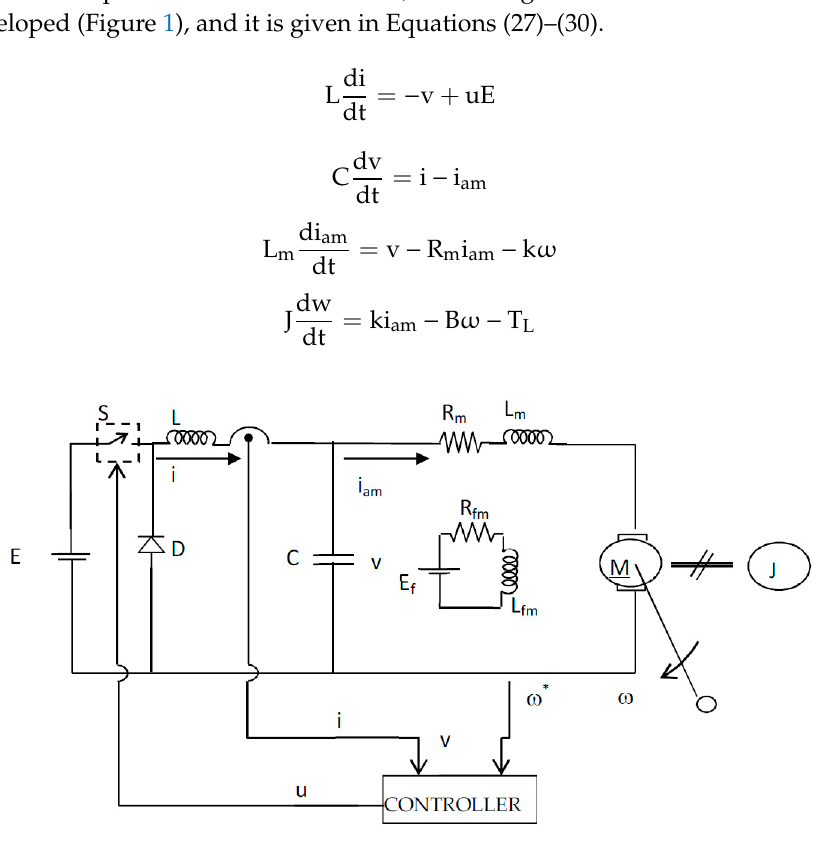
Figure 1. Exact tracking error dynamics passive output feedback (ETEDPOF) control of a buck converter.